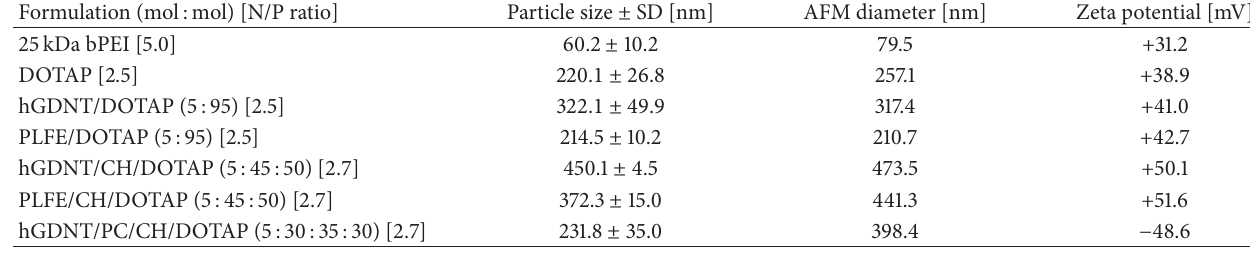
Table 2: Composition and physicochemical properties of polyplexes and lipoplexes.